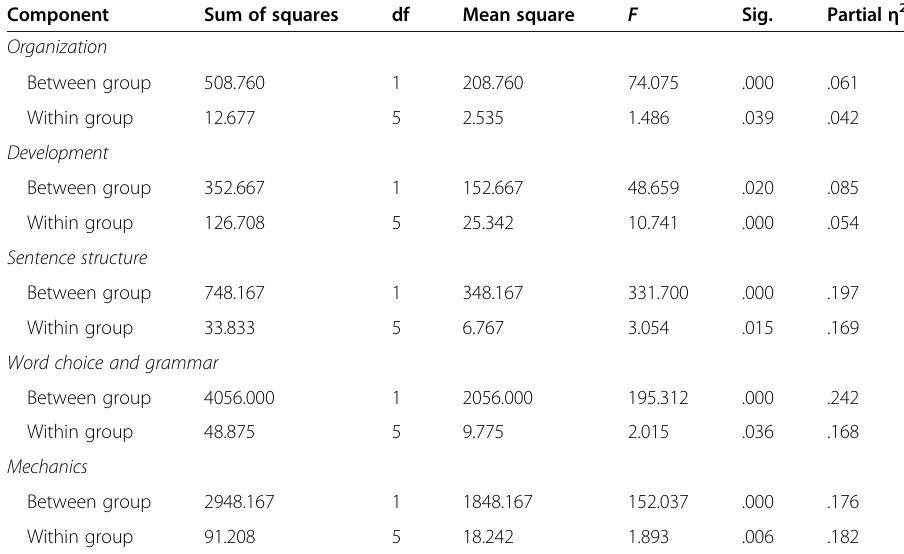
Feedback points on narrative writing tasks